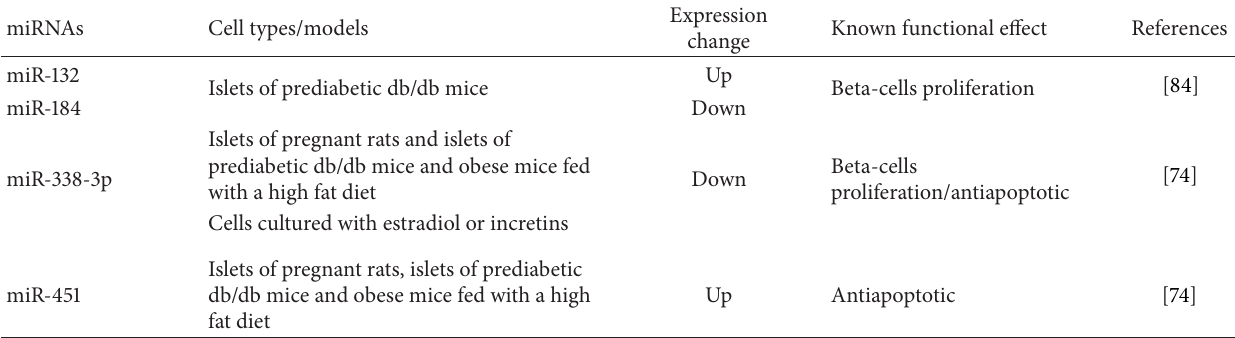
Table 3: miRNAs associated with compensatory